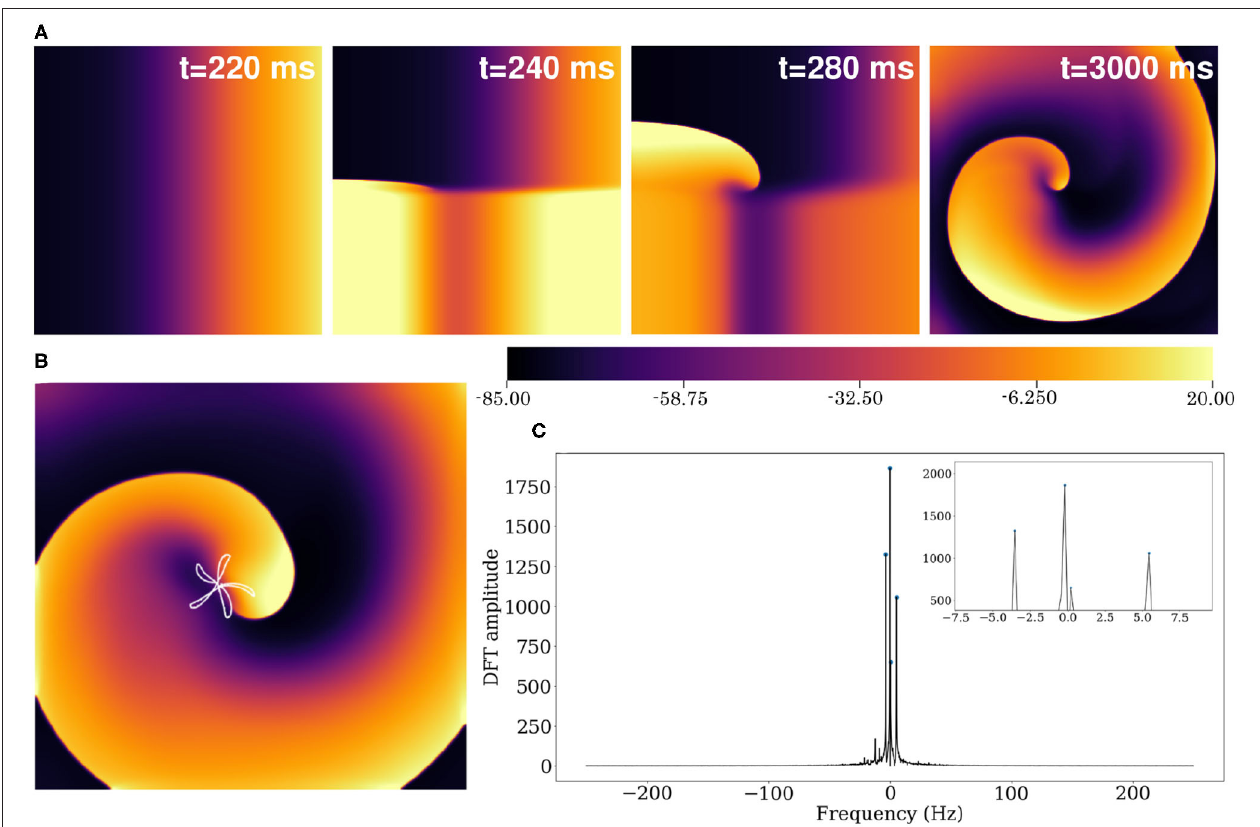
FIGURE 11 | (A) Formation of spiral waves in a 2D pig atrial tissue of size 11.26 × 11.26 cm 2 . Here t = 0 is considered as the time instant at which the S1 wave is initiated (as in Figure 10A ). (B) Hypocycloid pattern of the spiral tip trajectory. (C) Amplitude of the Discrete Fourier Transform (DFT) of the tip trajectory. The sampling frequency is F s = 500 Hz, and the corresponding resolution 1 f = 0.2089 Hz. The inset shows the 4 main peaks of the DFT.